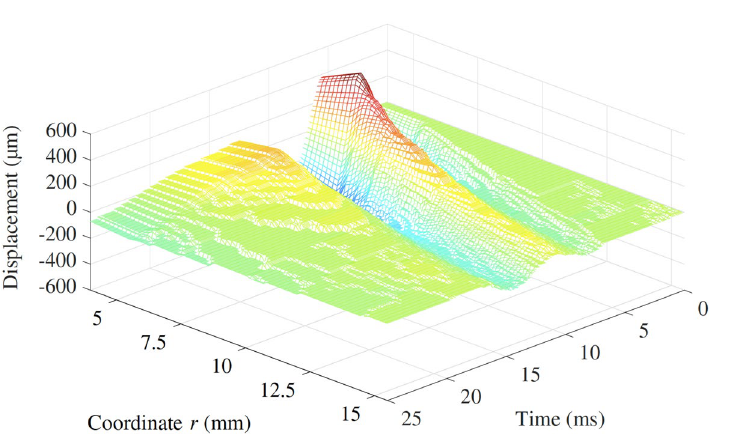
Figure 8. ( a ) Storage shear modulus and ( b ) loss shear modulus, as a function of frequency for the different gelatine concentration.